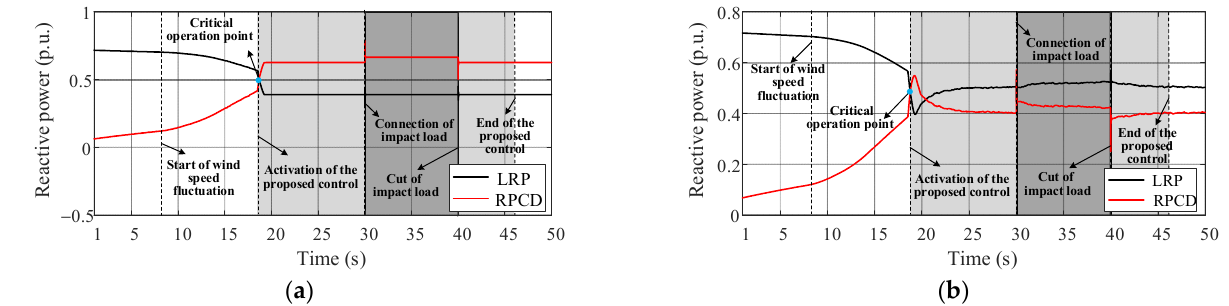
Figure 25. Real-time LRP and RPCD curves in case II. ( a ) Constant voltage control. ( b ) Active voltage coordinate control with HESS.